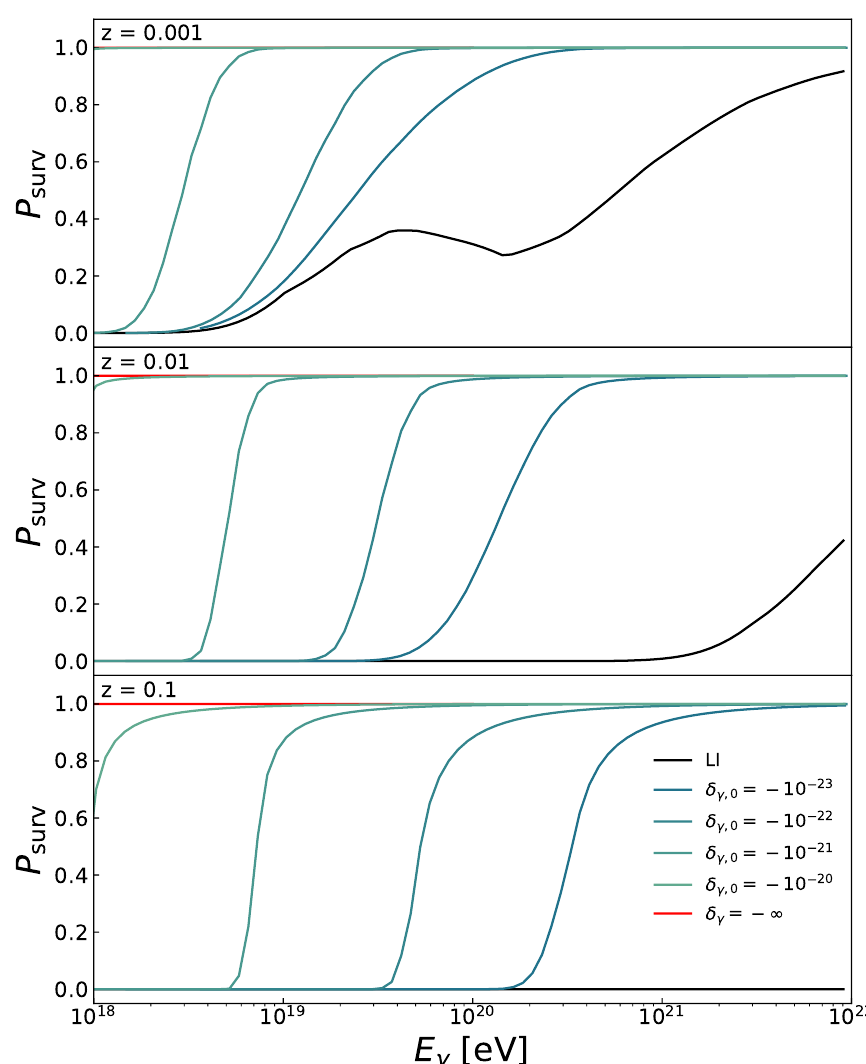
Figure 2. Survival probability as a function of the propagating photon energy. The black line and red line show the limiting cases, i.e., LI and maximum LIV, while the different colored lines show the results for different subluminal LIV coefficients. The three panels correspond to different values of